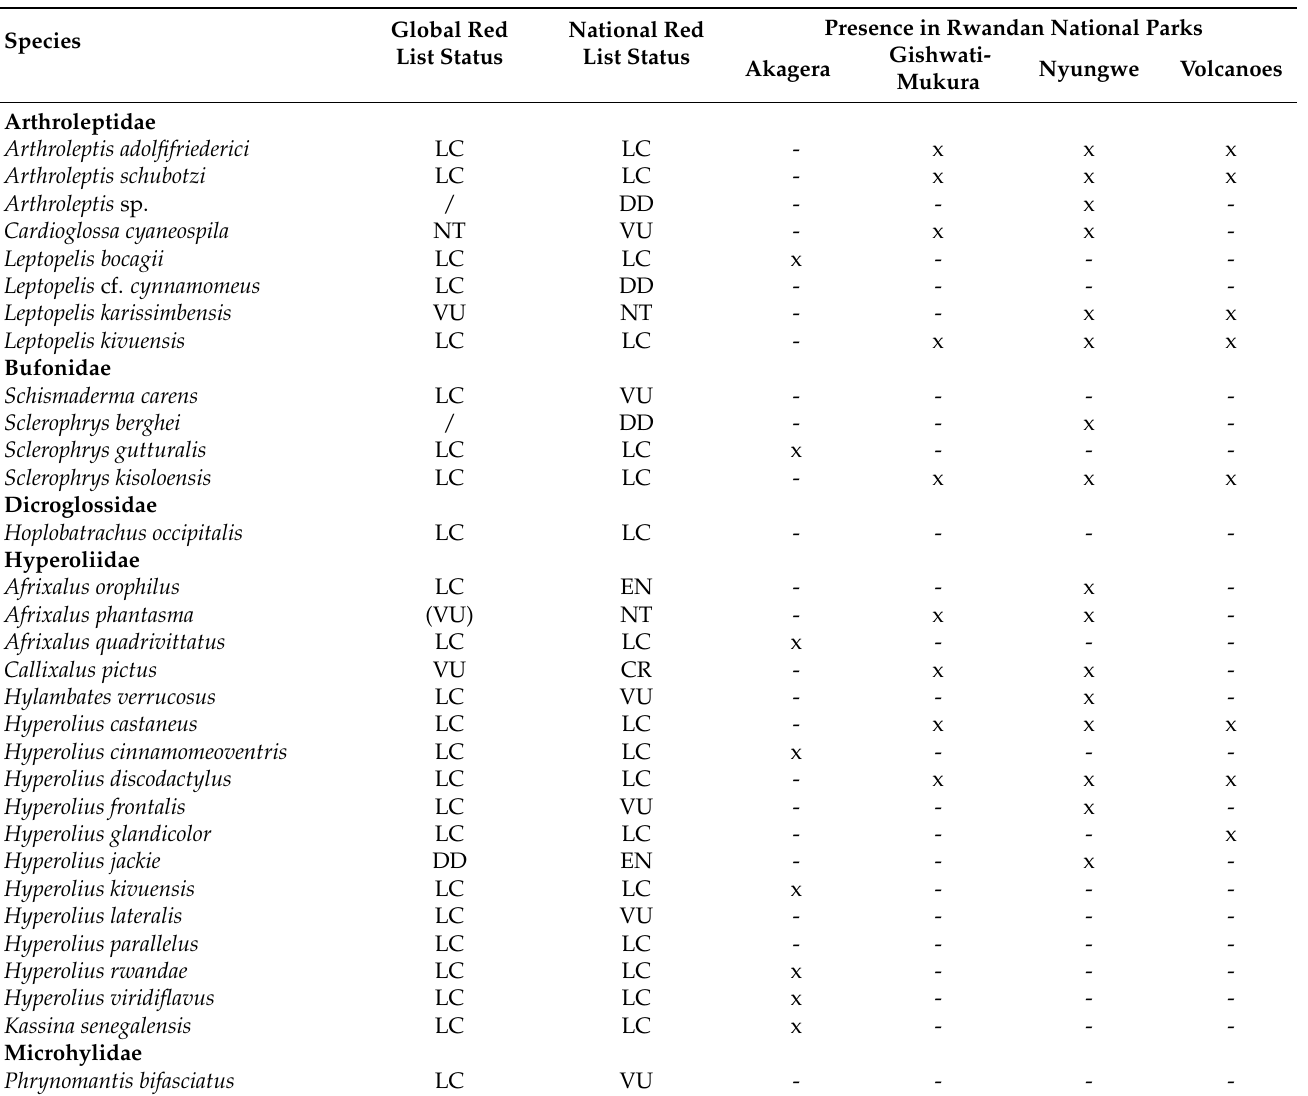
Table 1. Amphibian species in Rwanda, their global [7] and proposed national Red List status (CR = Critically Endangered, DD = Data Deficient, EN = Endangered, LC = Least Concern, NT = Near Threatened, VU = Vulnerable, / = not evaluated), and recorded presence in the four national parks (x = present, - = not recorded). The global red-list status of A. phantasma has been proposed by Ref.